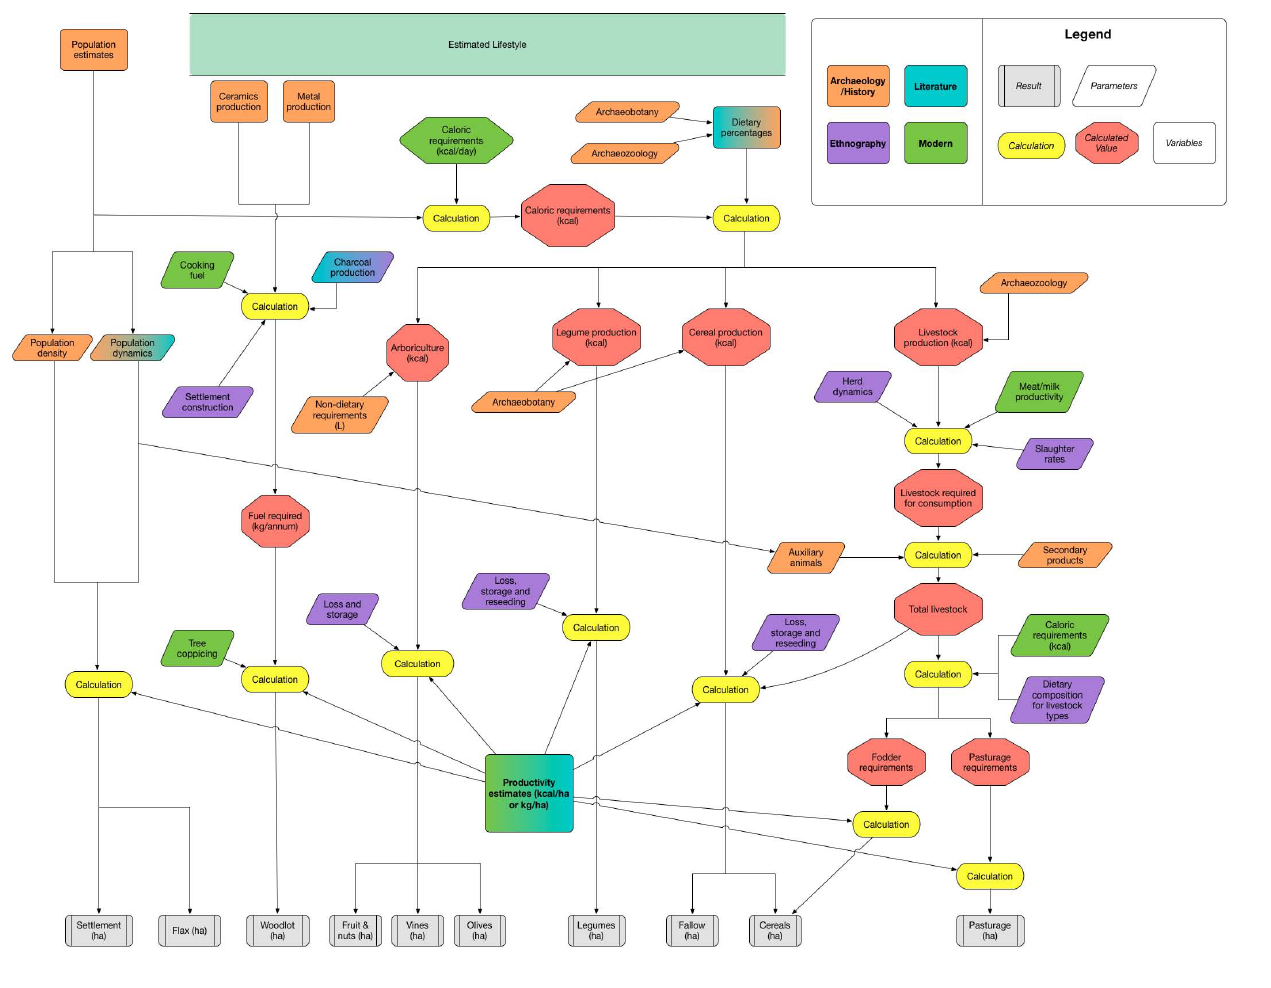
Figure 2. Simplified flowchart of the quantitative framework used to calculate the area of each element of the circle diagram. This framework is used to generate the circle diagrams presented in Figures 3 and 4 as well as